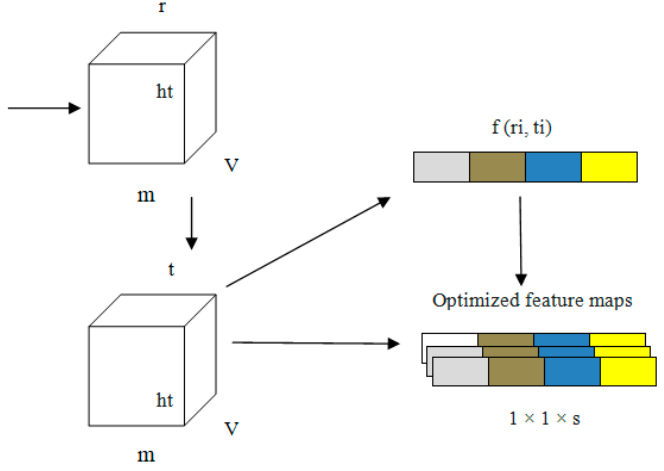
Figure 5. Structure of the channel optimizing technique (COT).